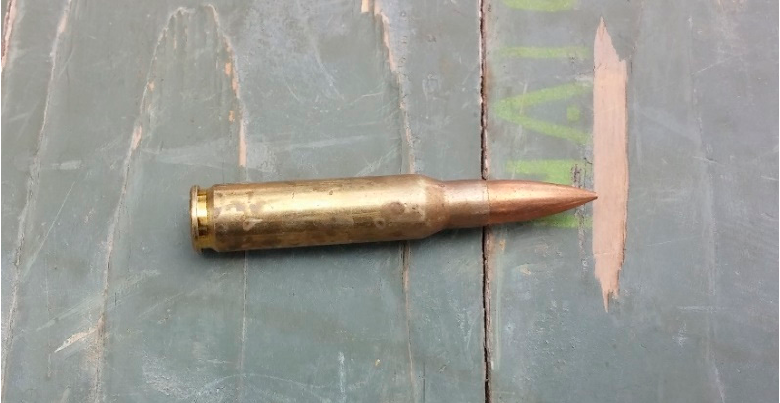
Figure 3. Initial shape of the bullet.